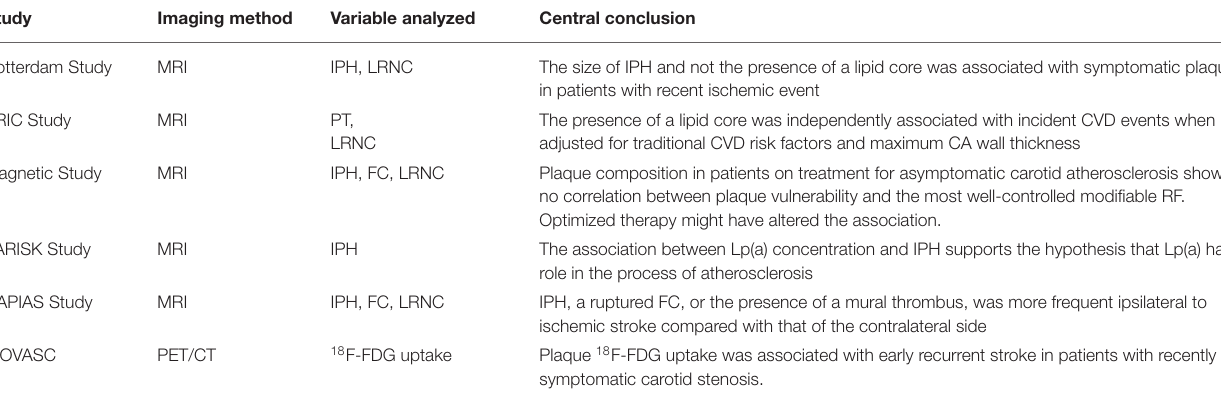
TABLE 1 | Imaging studies analyzing carotid plaque components and morphology on cerebrovascular risk in symptomatic and asymptomatic